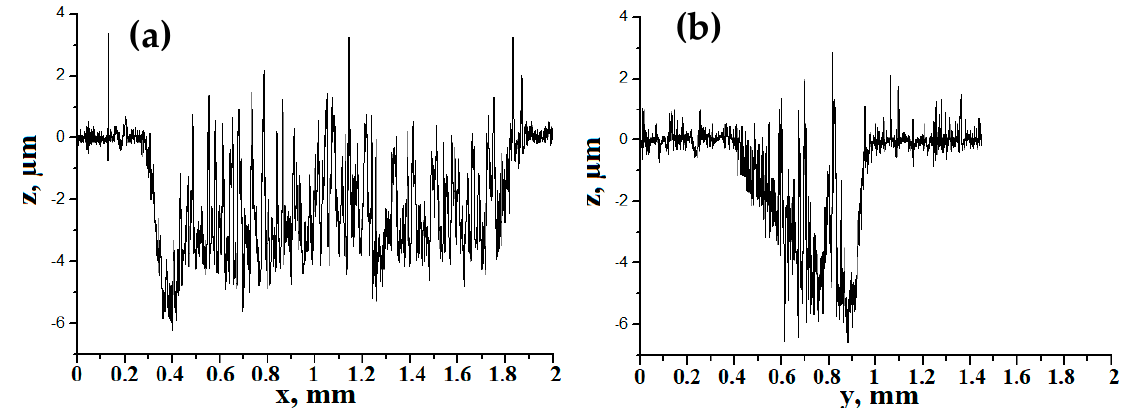
Figure 2. Typical ablation profiles for 21 J / cm 2 . The area with three scan repetitions (SR) was chosen for representation: ( a ) longitudinal profile of treated area bottom; ( b ) transversal profile of treated area bottom.